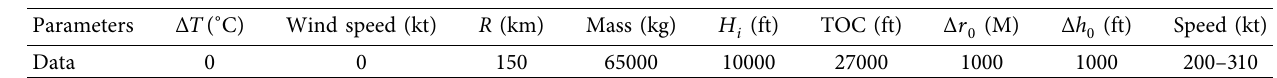
Figure 3: Multiple waypoint genetic algorithm optimization Table 1: Simulation basic parameters.